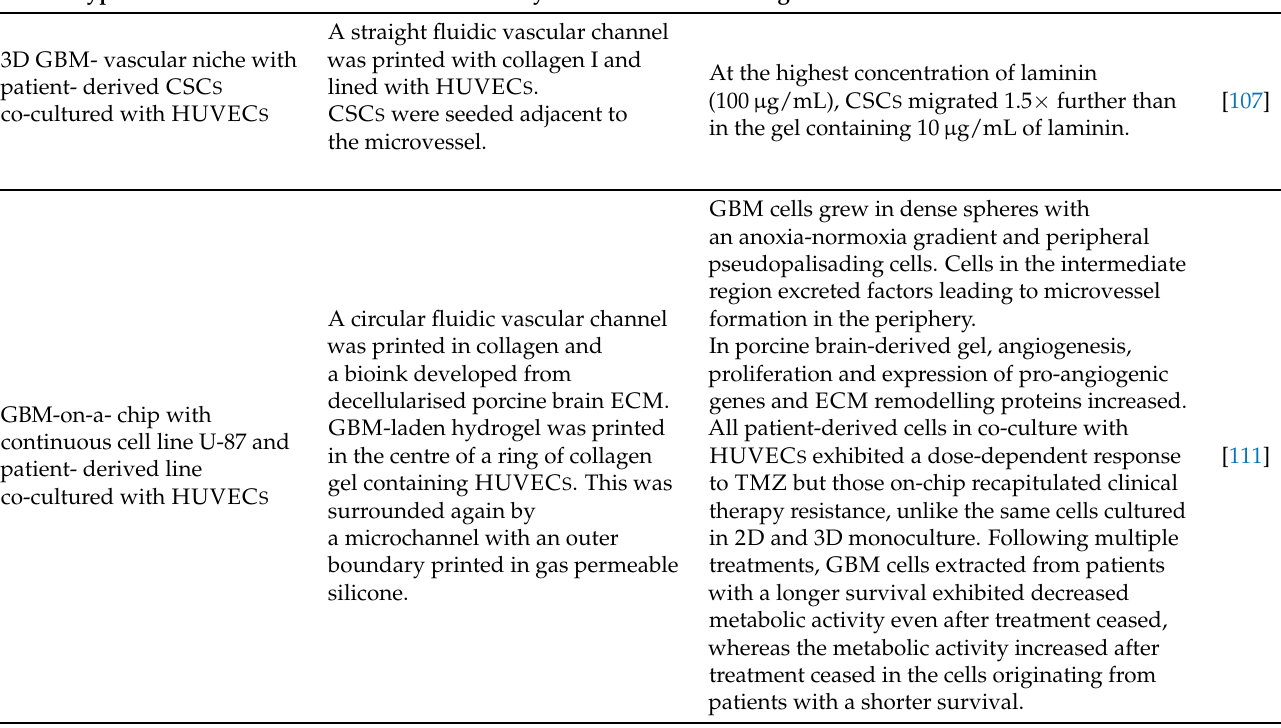
Table 8. Engineered organoid models of GBM incorporating a vasculature model. Model